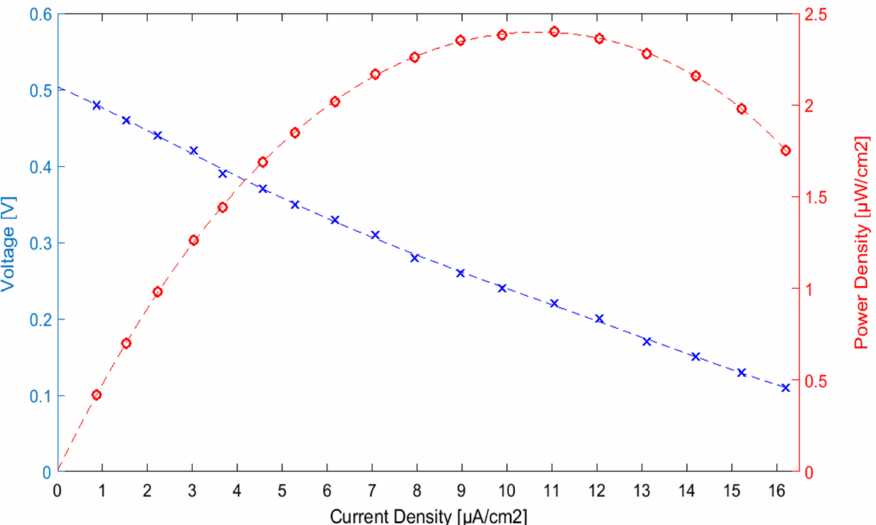
Figure 5. Polarization curve (blue crosses: measured data; blue dashed line: fitted data with a 5th order degree polynomial) and power density curve (red circles: measured data; red dashed line: fitted data with a 5th order degree polynomial) registered at day 0 for the studied